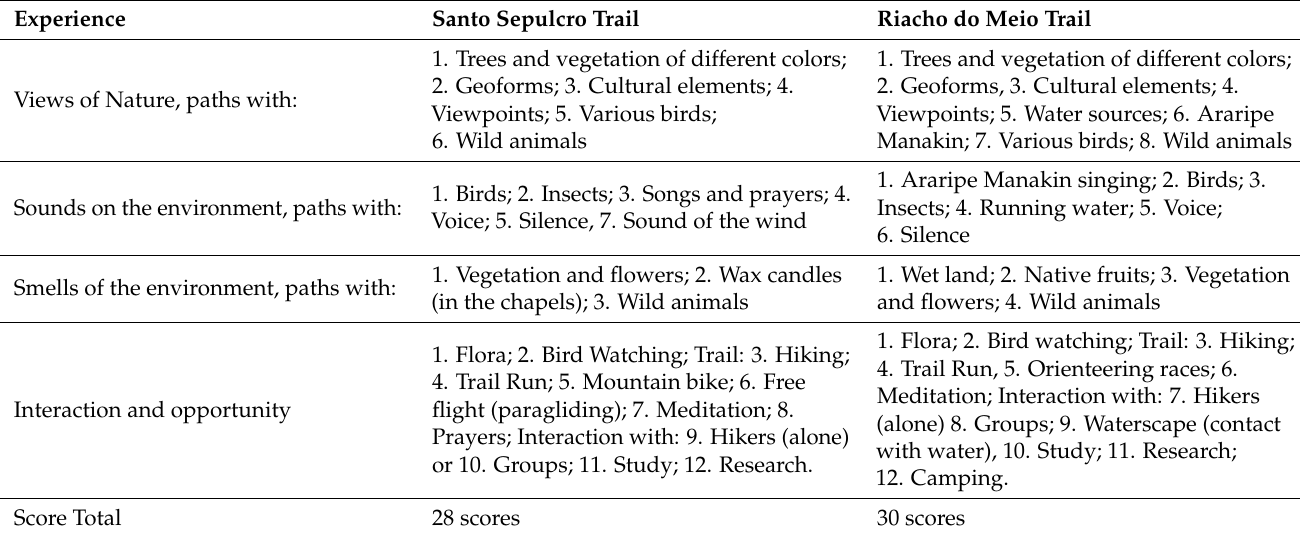
Table 5. Wellness experiences and health opportunities; Santo Sepulcro and Riacho do Meio trails.